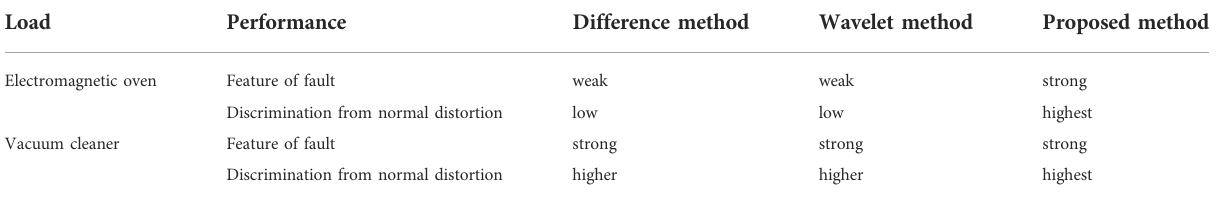
TABLE 2 Comparison of the effects of related methods.